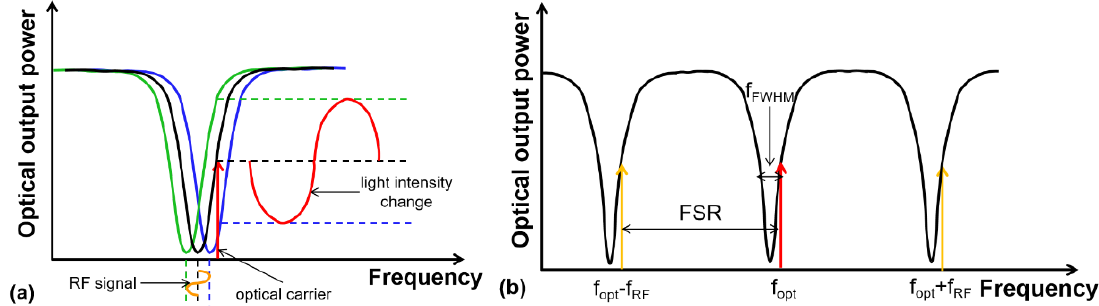
Figure 5. ( a ) Intensity modulation of microring resonator. The periodic change of RF signal (yellow line) causes the left and right drift of the microring transmission spectral line, which eventually leads to the periodic change of the intensity of the output laser (red line). ( b ) Microring modulation mechanism. The optical carrier is biased at the maximum slope of the microring transmission curve. When the RF frequency is equal to the free spectrum range (FSR) of the microring, the RF signal resonates in the loop together with the optical carrier to perform efficient electro-optical conversion.